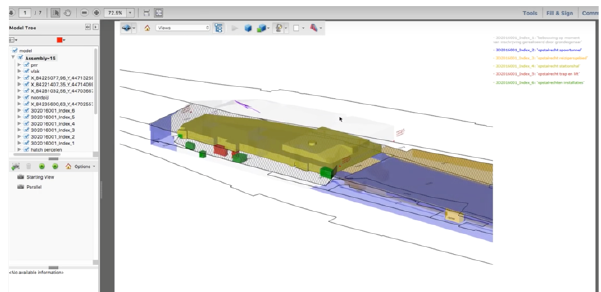
Figure 13 3D PDF, official document that visualises rights of multi- level ownership in 3D. It concerns the underground railway station in